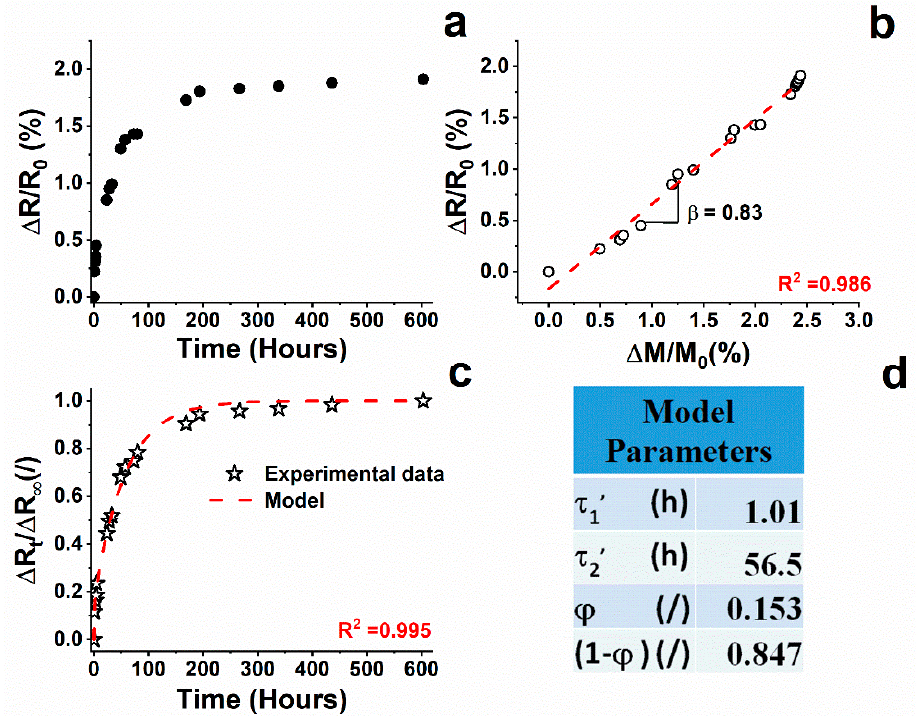
Figure 5. ( a ) Resistance change ratio ( ∆ R/R 0 ) as a function of the immersion time; ( b ) resistance change ratio ( ∆ R/R 0 ) vs. water amount percentage (symbols are experimental data, red line is calculated by linear fitting); ( c ) R t /R ∞ curves as a function of the immersion time (symbols are experimental data, red curve is calculated by fitting Equation (10)); ( d ) parameter values of Equation (10).